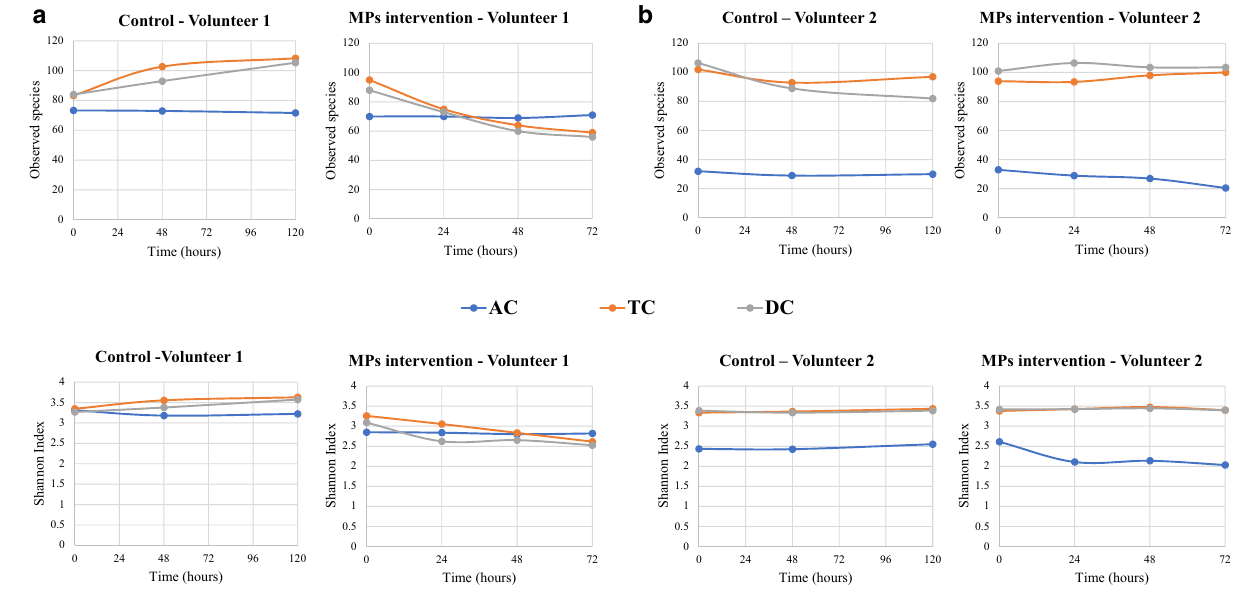
Figure 4. Evolution of the alpha diversity indexes for the different simgi colonic compartments during colonic fermentation. ( a ) show results for volunteer 1 and ( b ) for volunteer 2. AC ascending colon, TC transverse colon, DC descending colon.